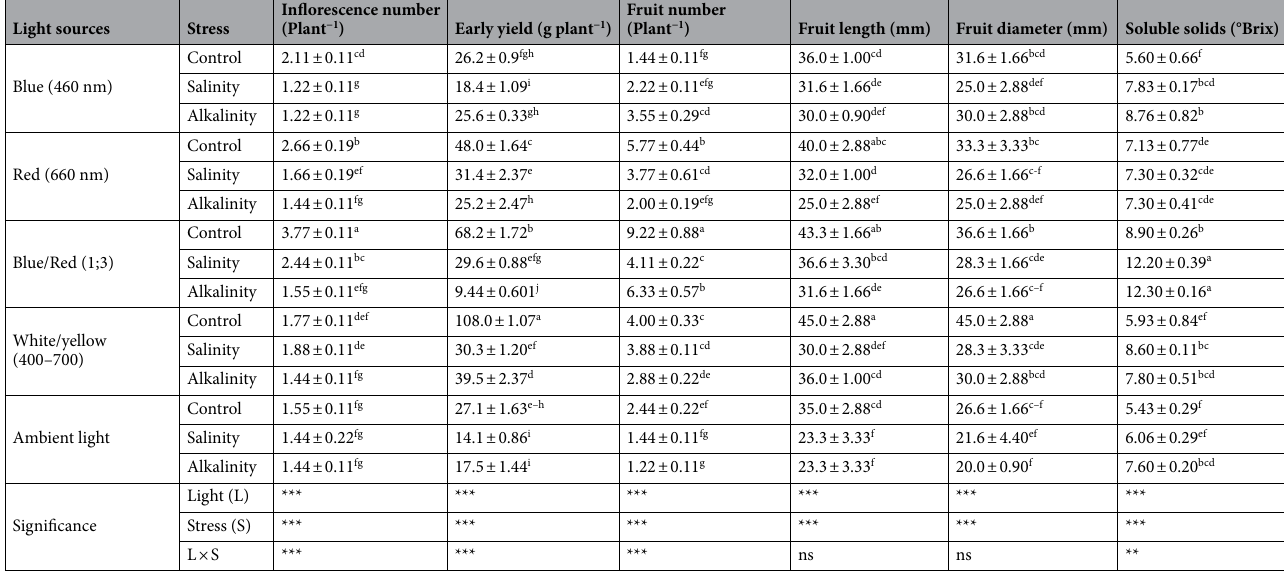
Table 4. Interaction of five levels of light spectrum and three levels of stress treatment on reproductive characteristics of strawberry cv. Camarosa. Values are means ± SE of three replicates. Bars with different letters show significant differences at P ≤ 0.05 (Duncan). Significance according to ANOVA, ns, *, **, ***, no significant and significant P ≤ 0.05, 0.01, 0.001, respectively. Control (no stress), salinity (80 mM NaCl)